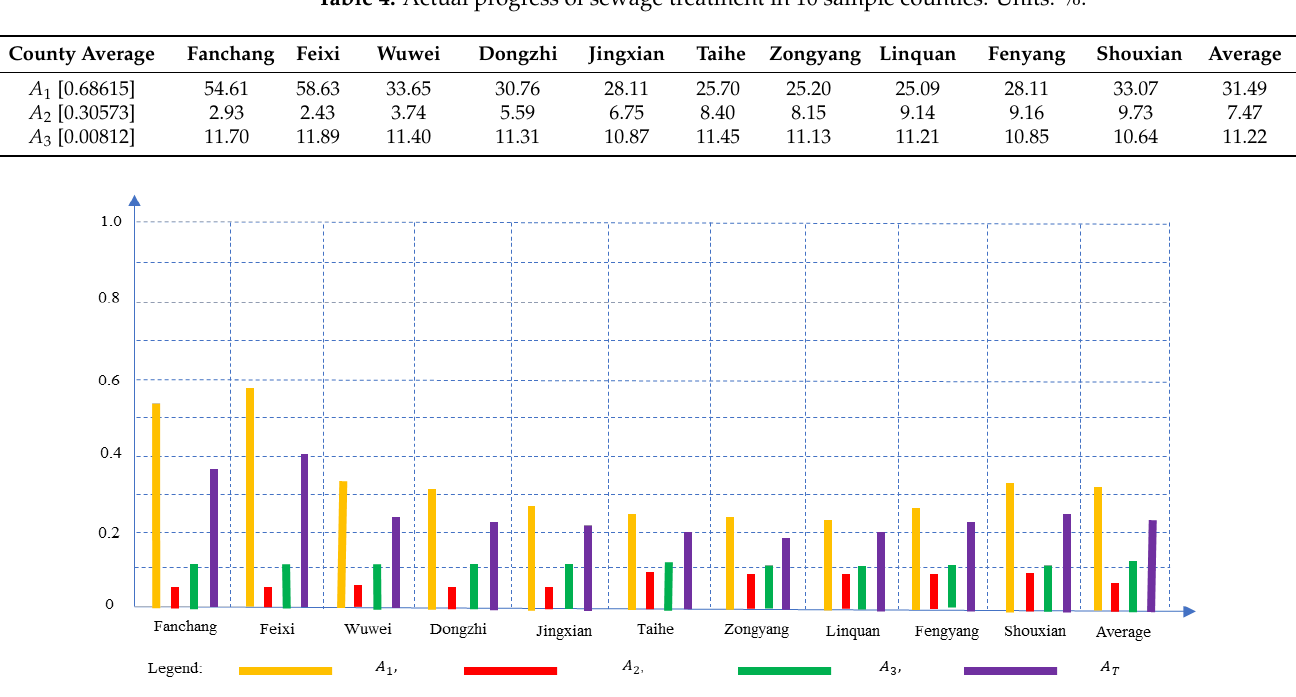
Table 5. Rural water environment quality of 10 sample counties in 2020.